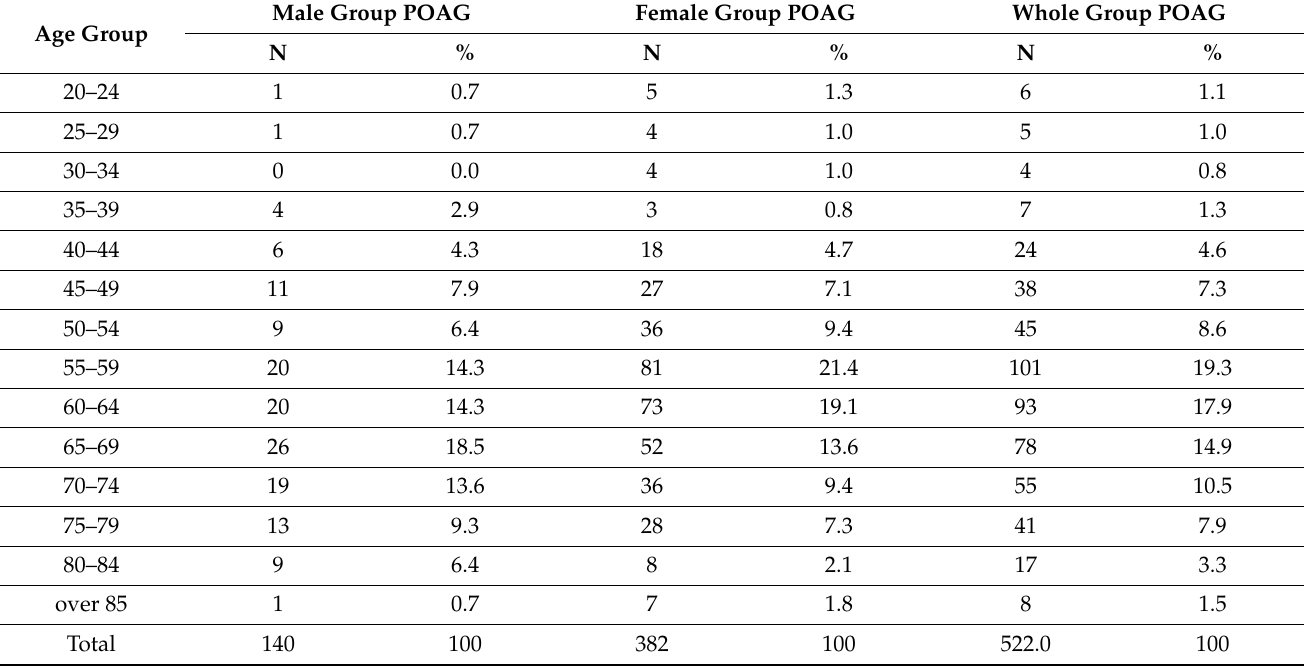
Table 3. Distribution of glaucoma patients by gender and age group at the first consultation.